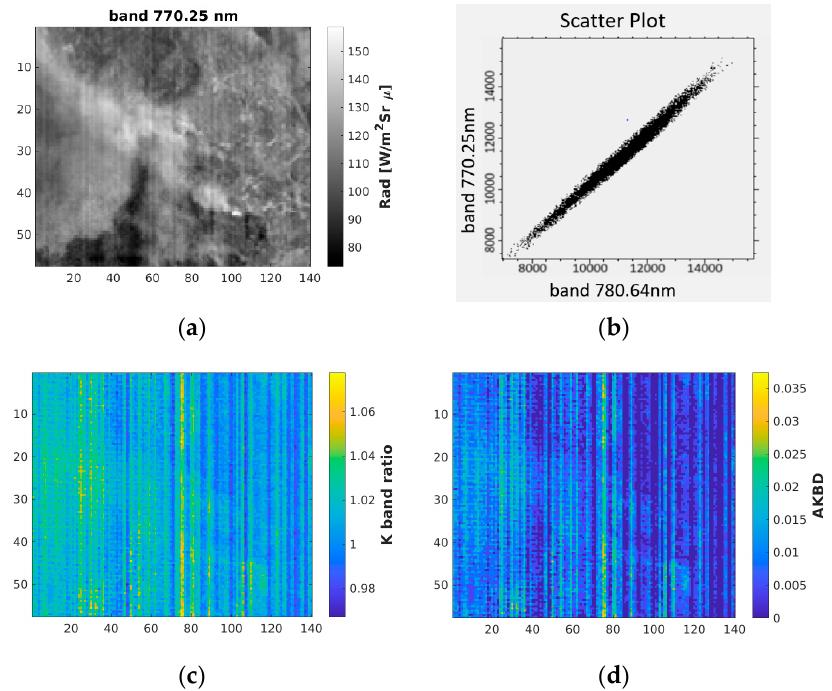
Figure 9. ( a ) Gray color PRISMA imagery at 770.25 nm; ( b ) scatter plot for PRISMA bands at 770.25 nm vs. 780.64 nm, showing high correlation between band where potassium emission is expected and that for the background; ( c ) potassium emission band ratio; ( d ) advance K band difference (AKBD) normalized index map.